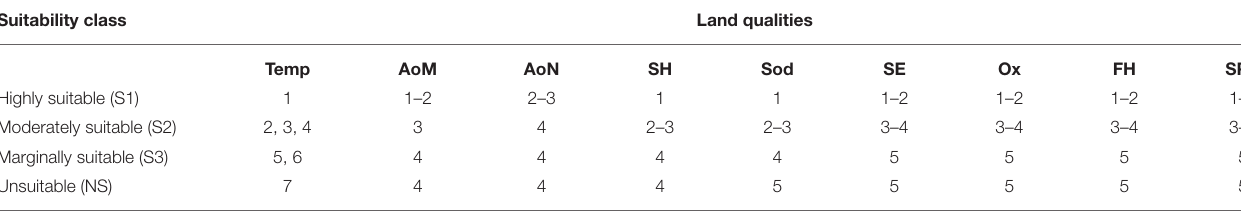
TABLE 7 | Decision matrix for the suitability classification of soils for rainfed maize growing under the intermediate technology option [Table 40 in (42)]. Suitability class